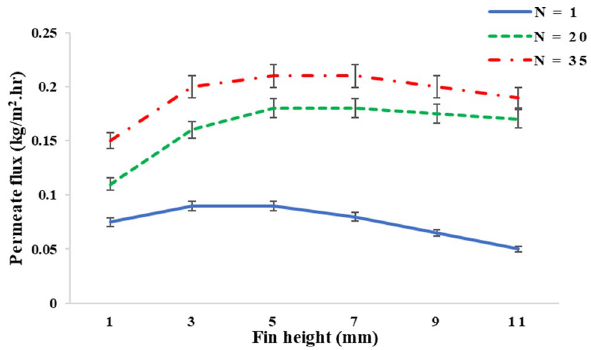
Fig. 16 Effect of design parameters on GOR with operating param- eters fixed to the baseline